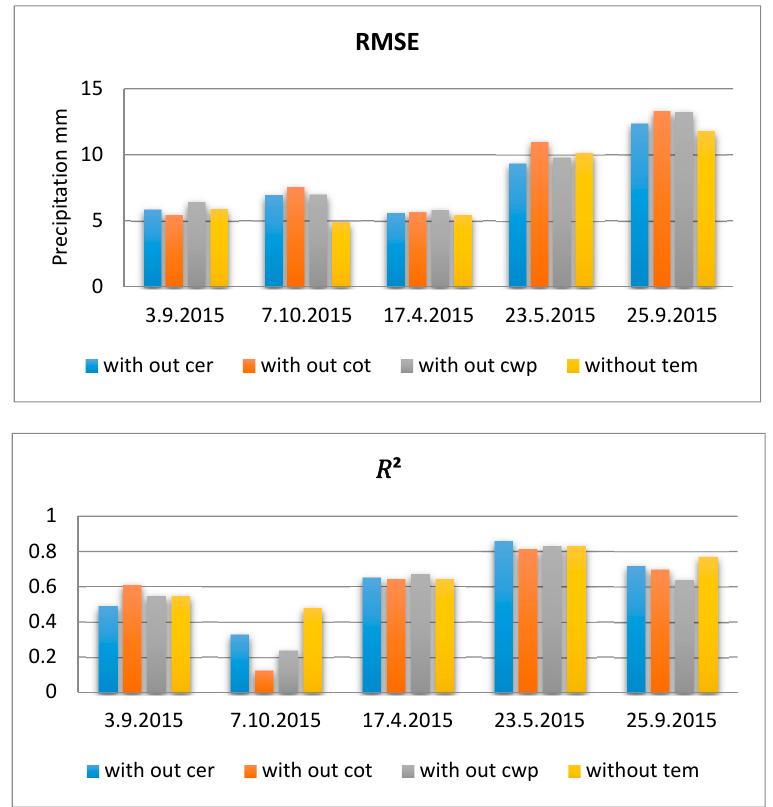
Figure 9. Sensitivity analysis of error calculation for a) RMSE and b) R-squared ( 𝑹 𝟐 )